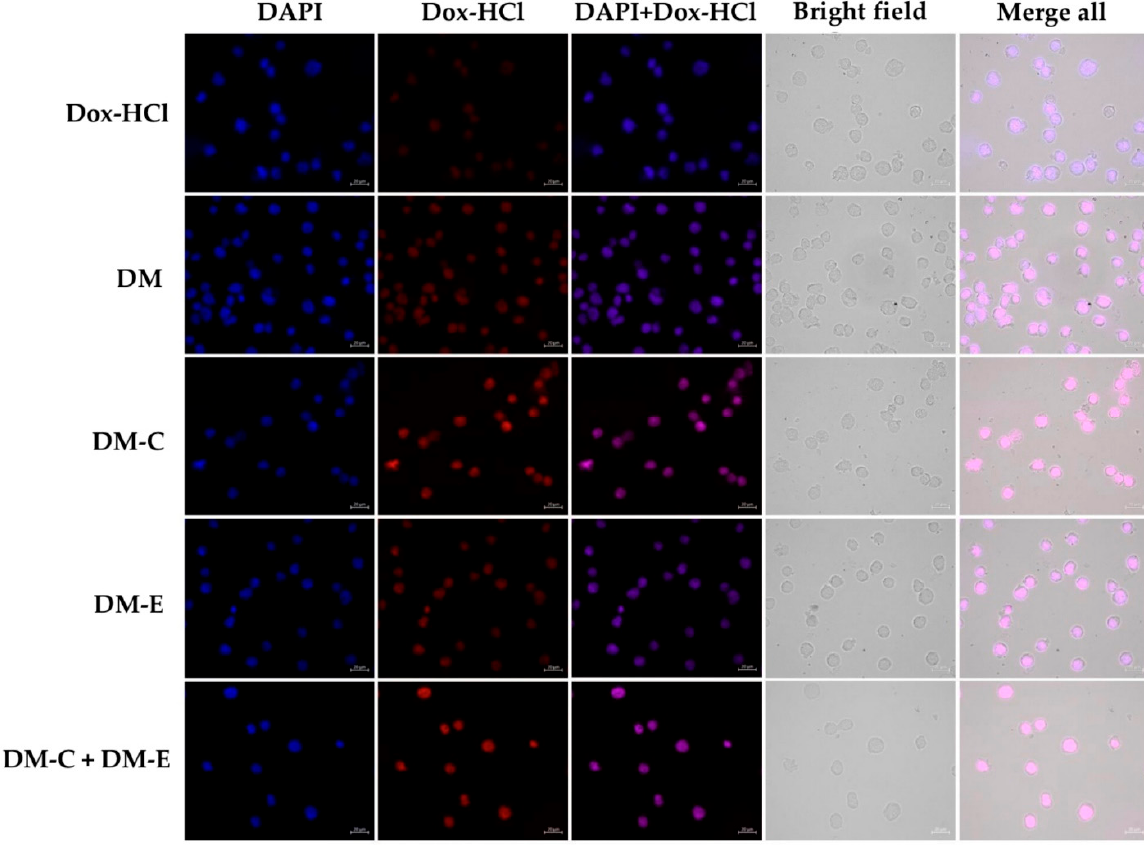
Figure 13. Dox intensity images of Dox-HCl, DM, DM-CKR (DM-C), DM-EVQ (DM-E), and DM- CKR+DM-EVQ (DM-C+DM-E) after 5 h of incubation with KG-1a cells, examined under a fluores- cence microscope. Cells were counterstained with DAPI to represent nuclei (scale bar: 20 µm).